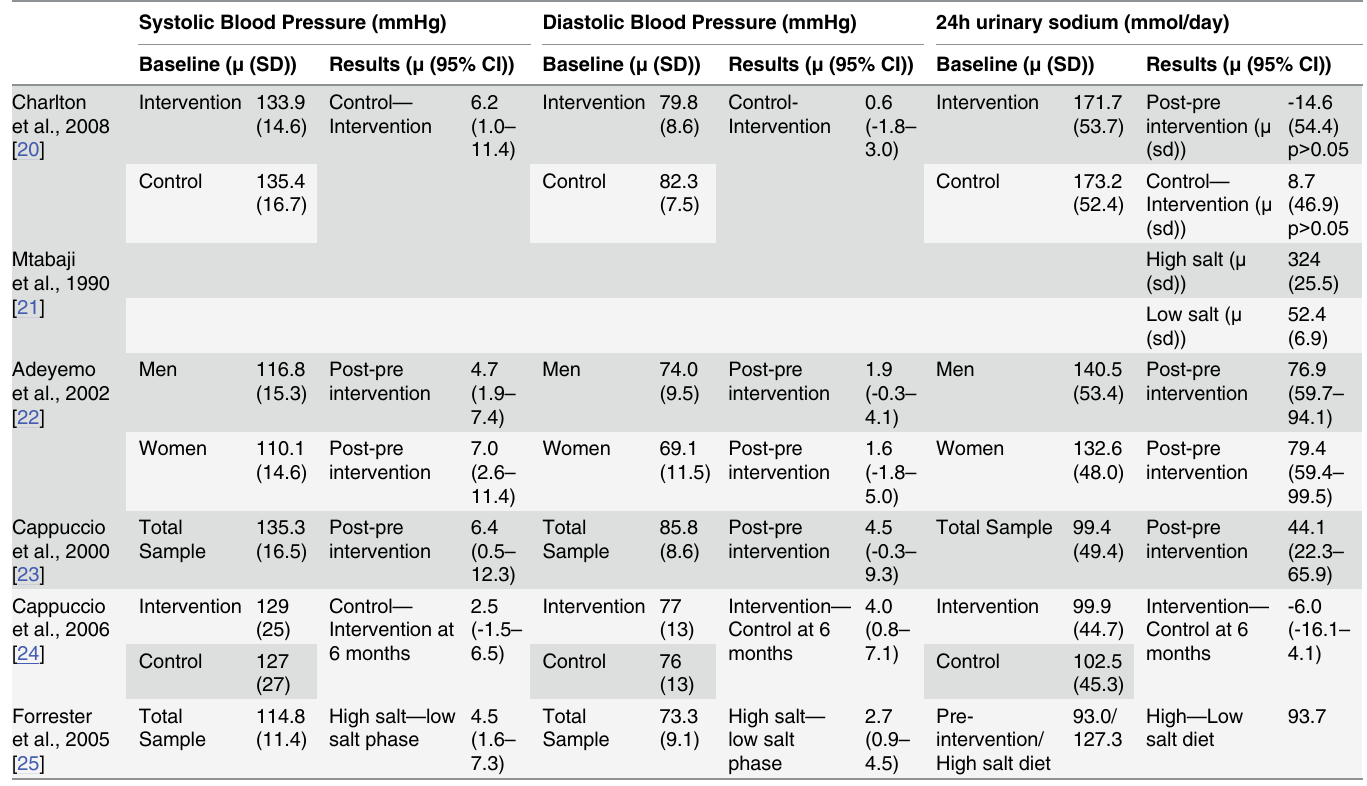
Table 4. Quantitative results from included